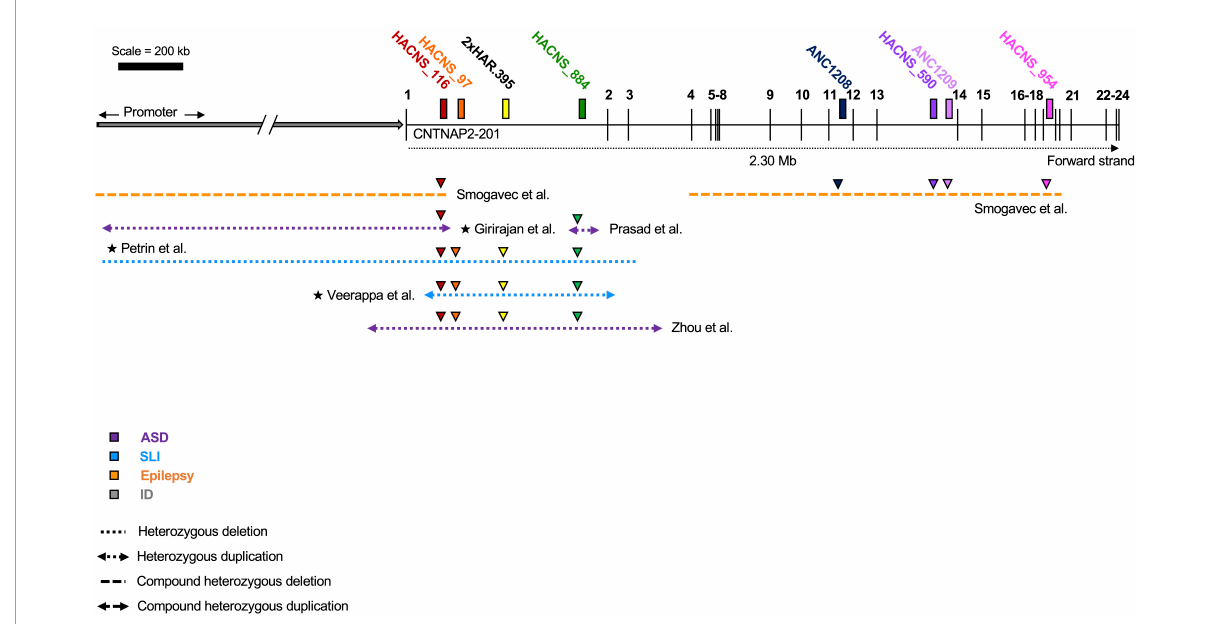
Eight HARs lie within the CNTNAP2 locus. Of these, four are located within intron 1 and two are located in intron 13. The number of human-specific nucleotide substitutions is shown in column 5, followed by the number of these substitutions that are polymorphic in humans (column 6), the number shared in Neanderthals/Denisovans (column 7), and the number of substitutions that are G / C in humans from A / T in other primates (i.e., weak to strong). The majority of CNTNAP2 HARs appear to be composed of fixed substitutions that are shared witharchaichumans.Between1/4and1/2areweaktostrongtransitions.CoordinatesmaptohumangenomeGRCh38;originalsourcesdescribingeachHARareshowninbrackets.Data adaptedfromHubiszandPollard(2014).